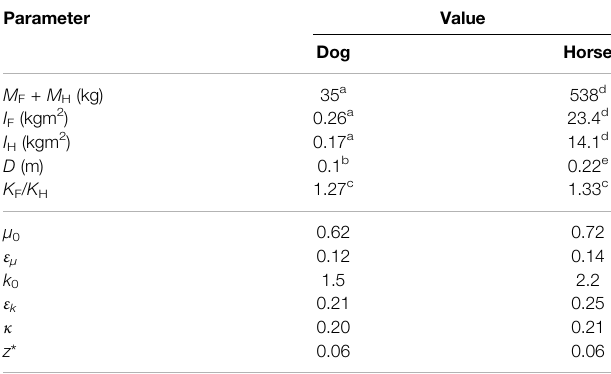
TABLE 1 | Parameters of dog and horse models. μ 0 , ε μ , and ε k are determined based on the measured data of animals and k 0 , κ , and z * are determined through the optimization of